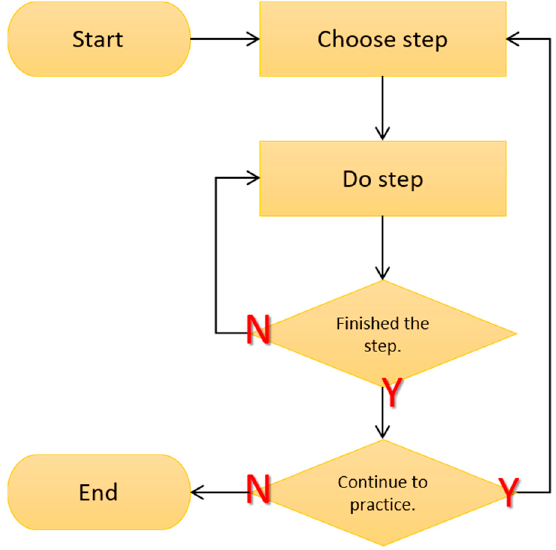
Figure 15. The flowchart of the practice